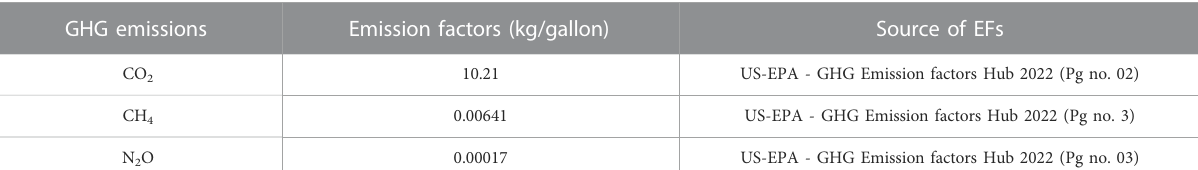
TABLE 3 GHG emission factors (EFs) for diesel.